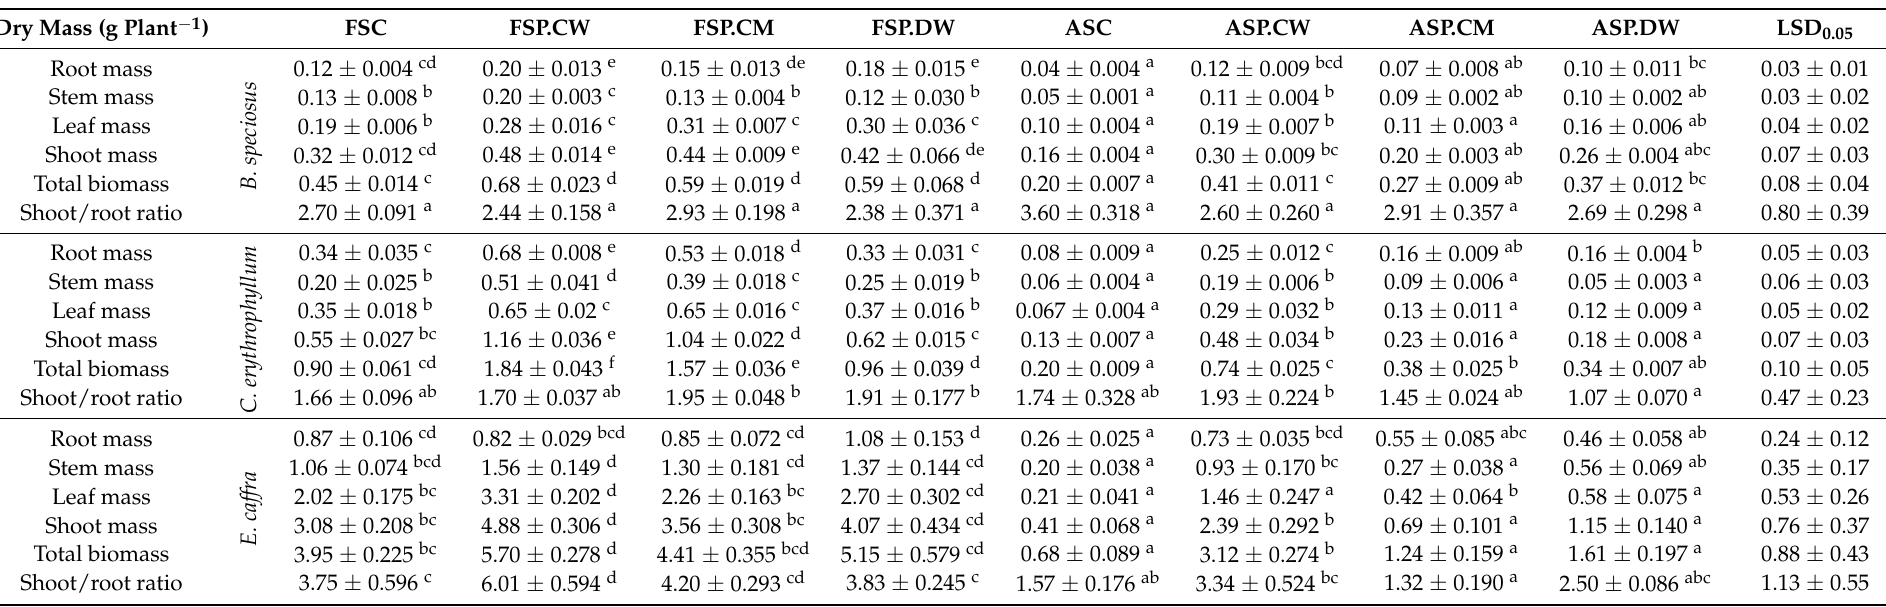
Abbreviations as for Table 2. ANOVA was performed across treatments. The means of replicate was separated at LSD 0.05 . Post hoc was done using a Tukey test. Means along the same row with different letters were significantly different ( p < 0.05, n =